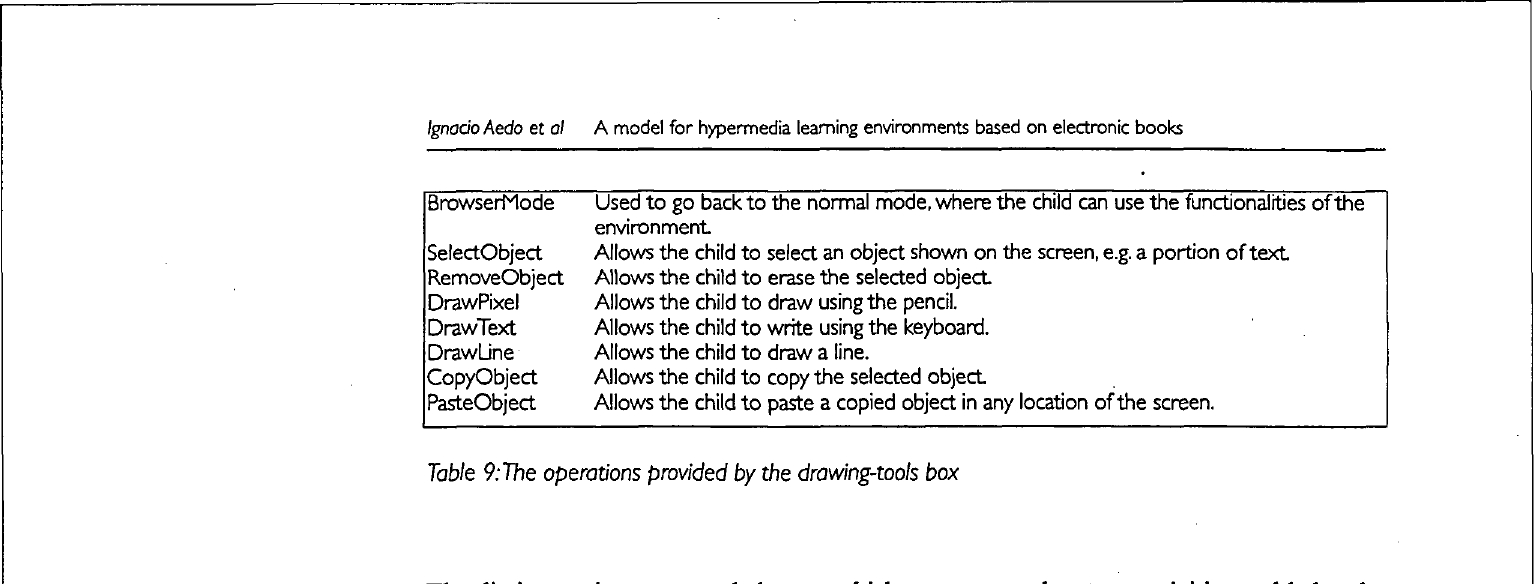
The dictionary is an external element which supports explanatory activities and helps the child to advance in the language-learning process. The dictionary consists of words with different meanings, each of which includes a description and a sample situation. This information is available both in written and sign language. In addition, each word-entry contains its labial form. The dictionary can be also used as an independent object. Its use is recommended to the children in the intermediate and highest levels. The operations available in the dictionary are listed in Table